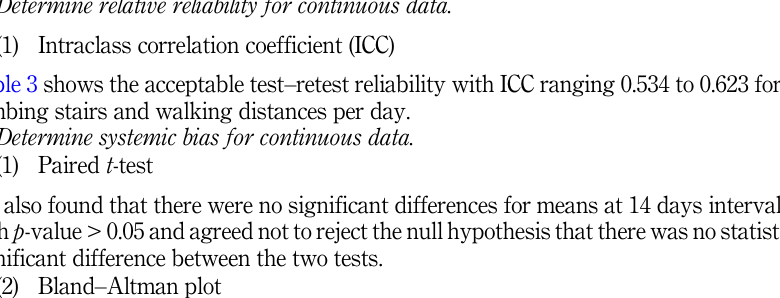
Table 4. Cronbach ’ s alpha on each component and their proposed names for Malay version